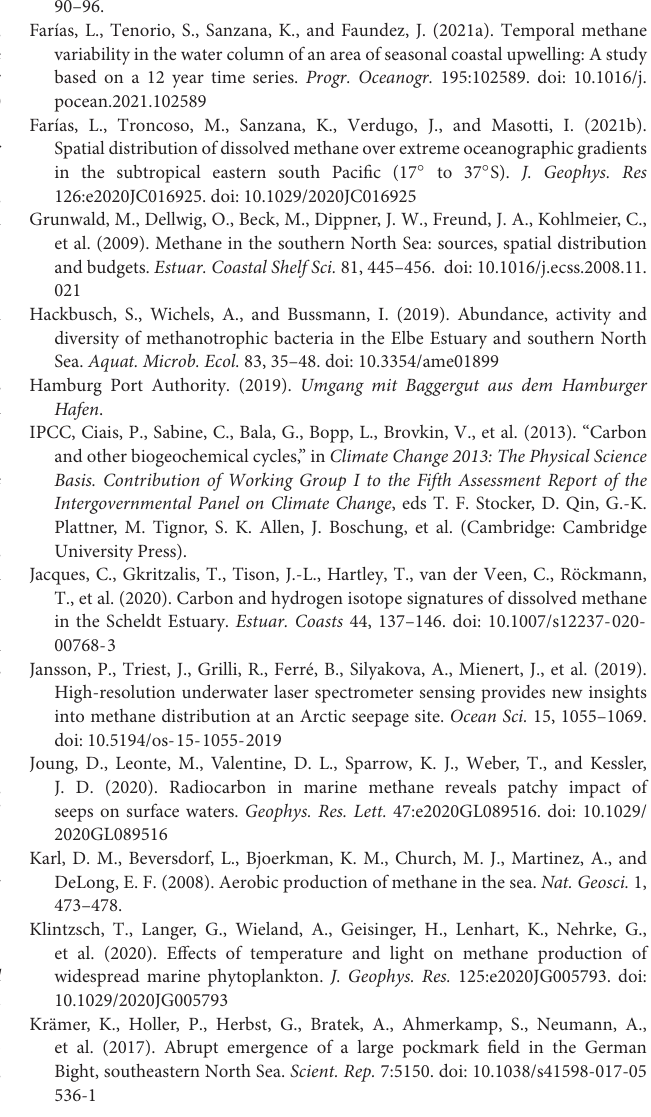
Supplementary Figure S2 | Dilution of Elbe water 25 June. The boxes indicate the riverine and marine part. Supplementary Figure S3 | Delta 13-C of CH4 versus the inverse CH4 concentration (Keeling plot). Circles indicate data from RV Uthörn, squares data from RV Prandtl. Red triangles indicate riverine stations, their location is shown in Figure 3 . The regression line is based on all data. Supplementary Figure S4 | Location of stations above E1, E2) and on (W1, W2) the dilution line for Weser water with marine endmember on 26th June. Supplementary Figure S5 | The diffusive methane flux in the marine area (solid line with S > 30), in the estuarine area (dashed line with 25.1 < S < 29.9) and riverine area (dotted line with S > 25). Supplementary Figure S6 | Discharge of the rivers Elbe (at Neu Darchau, in black) and Weser (at Intschede, in blue) in 2019. Vertical line indicates the date of our cruise and the dotted line 3 weeks